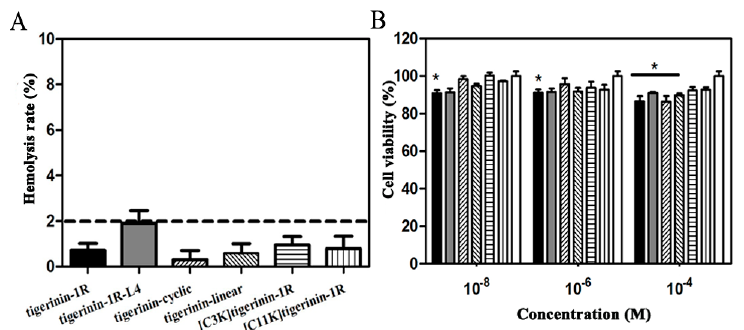
Figure 2. Cellular toxicity of the peptides. ( A ) The calculated hemolysis rate of peptides of 250 μ M after incubation with 70 μ L human erythrocytes for 2 h. Hemolysis was denoted as the values greater than 2% (the dotted line). ( B ) The viability of INS-1 cells following incubation with peptides of different concentrations for 24 h. Columns used are as follows for both graphs: black solid column for tigerinin-1R; gray solid column for tigerinin-1R-L4; left slash filled column for tigerinin-cyclic; right slash filled column for tigerinin-linear; horizontal line filled column for [C3K]tigerinin-1R;vertical line filled column for [C11K]tigerinin-1R; open column for negative control (* p < 0.05 compared with negative control; n = 3).